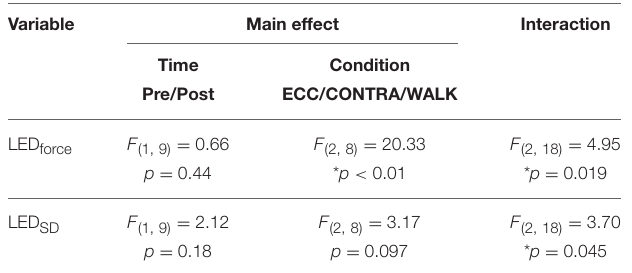
TABLE 1 | Summary of repeated measures ANOVA results from the exposure group. Variable